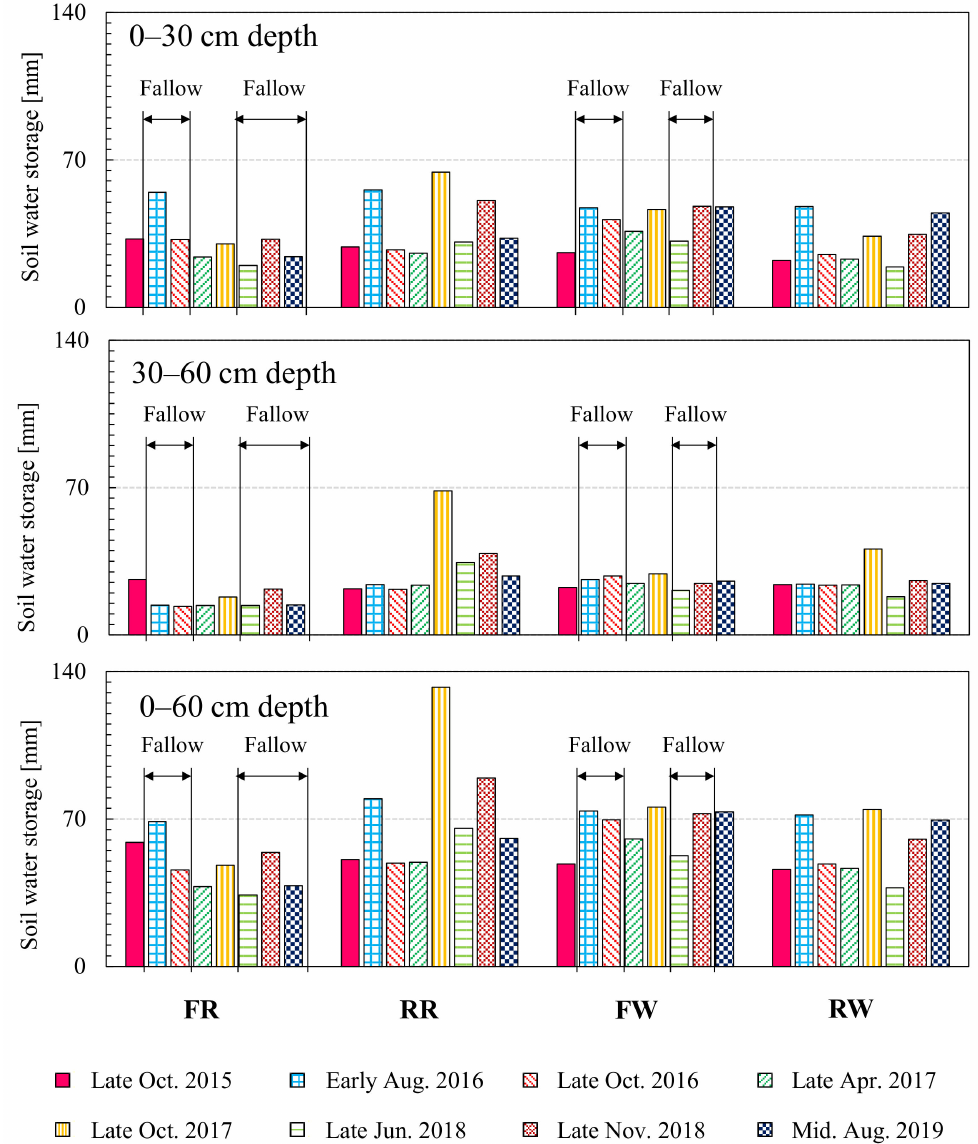
Figure 9. Changes in soil water storage in the root zone (0–30 cm depth), below the root zone (30–60 cm depth), and in the depth of 0–60 cm at the study sites from 2015 to 2019. FR is the rapeseed field, FW is the wheat field, RR is the rangeland adjacent to FR, and RW is the rangeland adjacent to FW. “Fallow” indicates as fallow year in FR and